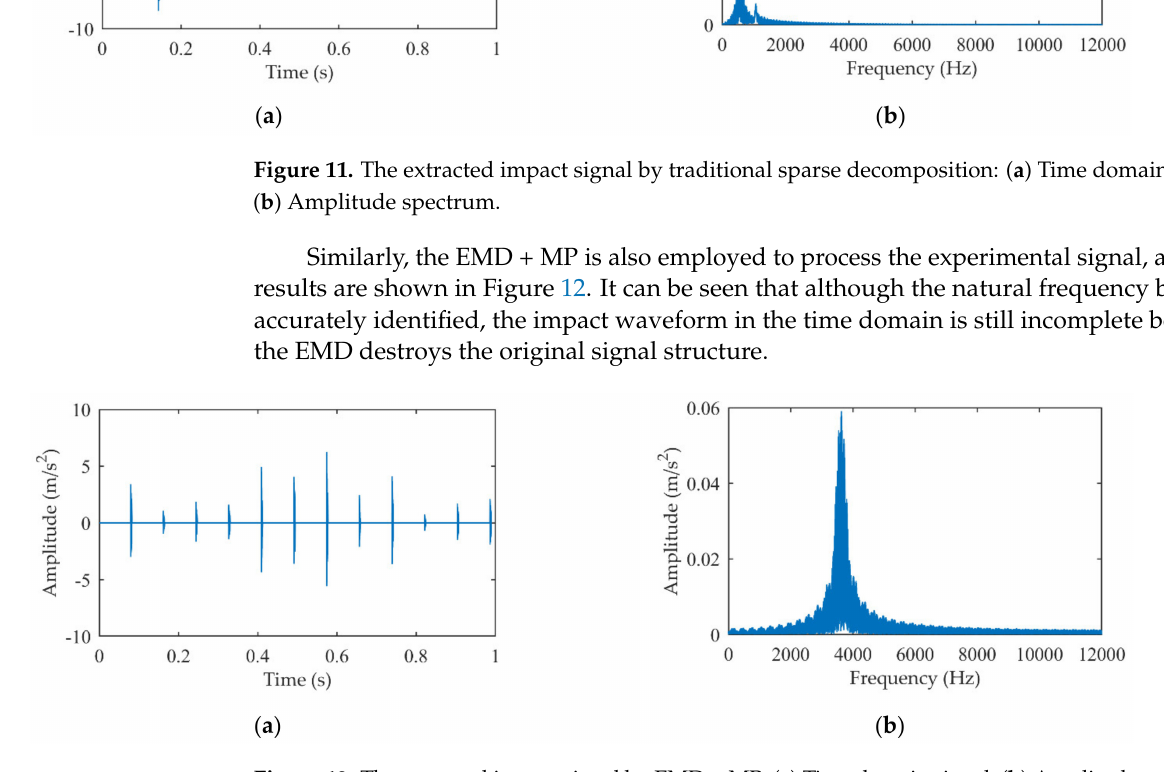
Figure 12. The extracted impact signal by EMD + MP: ( a ) Time domain signal; ( b ) Amplitude